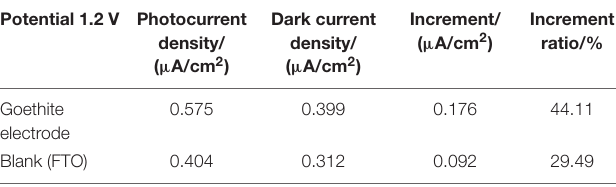
TABLE 1 | Current density of goethite electrode under light and dark (voltage: 1.2